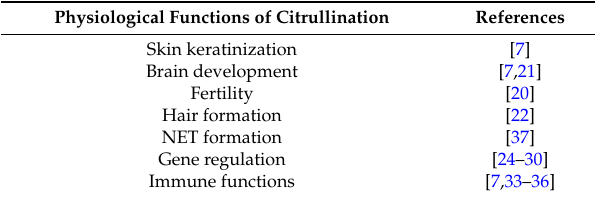
Table 1. Physiological functions of citrullination mediated by peptidylarginine